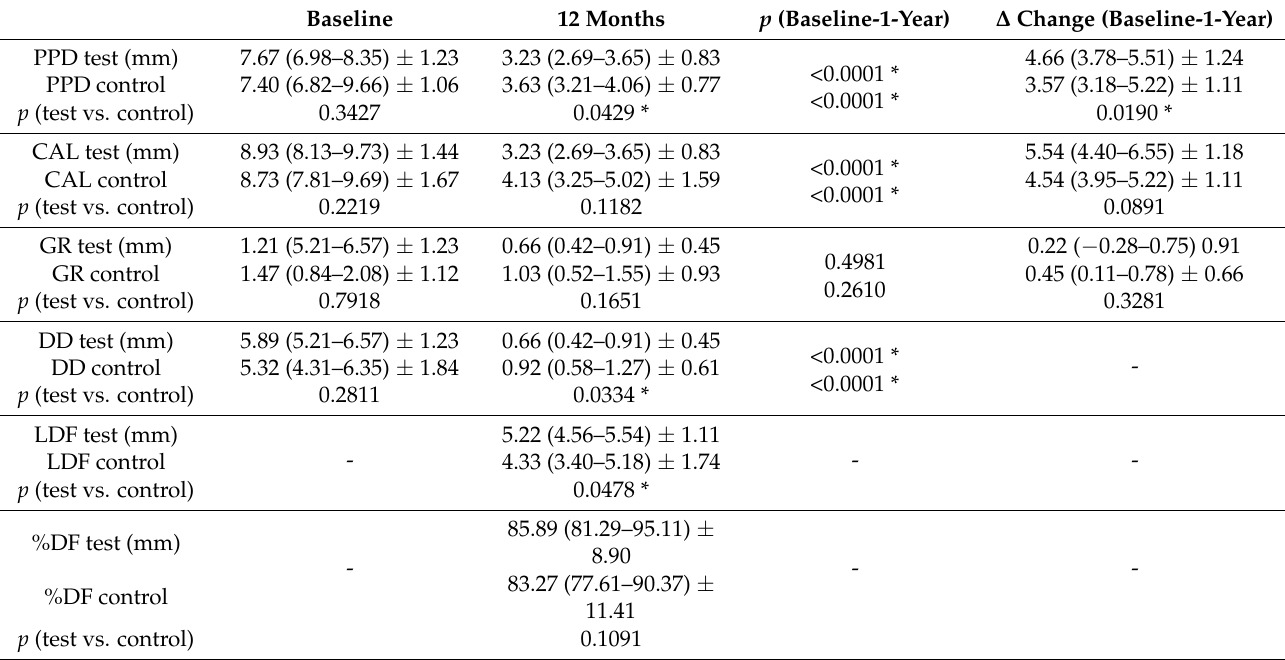
Table 2. Baseline clinical characteristics: tooth type, tooth position, radiographic angle (RVG angle), intra-surgical measurements and defect morphology [mean, 95% confidence interval (CI), standard deviation (SD)].